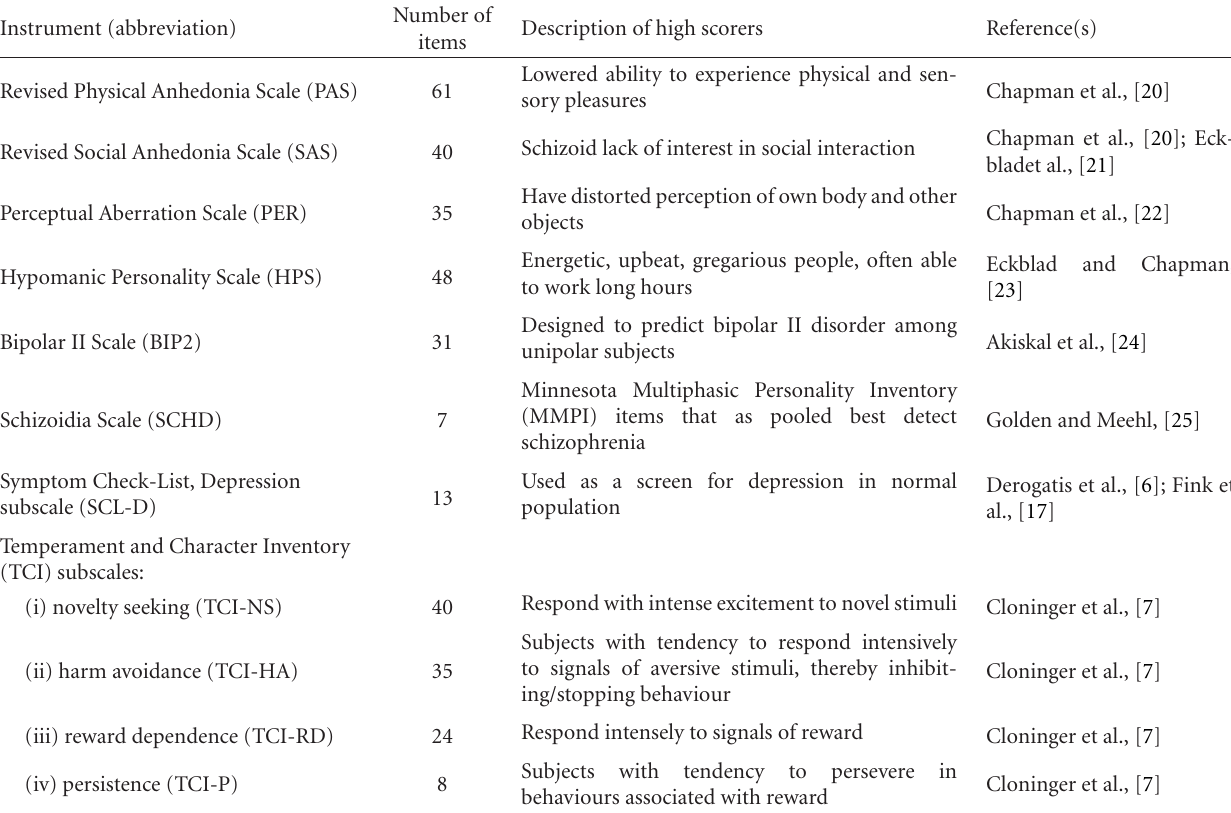
Table 1: Psychological scales used in the 31-year followup of the Northern Finland 1966 Birth